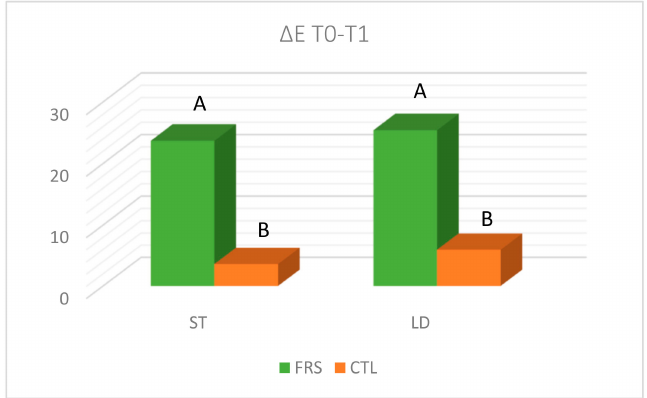
Figure 1. Variation of colour ( ∆ E) during the first 30 days (T0-T1) of PDA in bu ff aloes fed with (FRS) or without (CTL) rye grass in Semitendinosus (ST) and Longissimus (LD) muscle. A, B, Bars with di ff erent letters are significantly di ff erent; p < 0.01